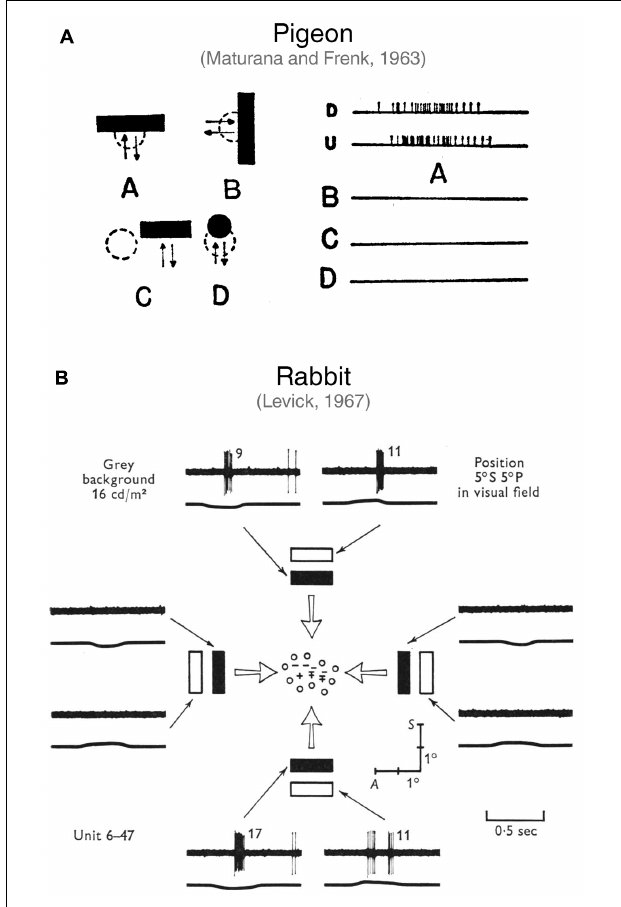
FIGURE 2 | First studies describing orientation-selective ganglion cells in vertebrate retinae. (A) Discovery of horizontally tuned OSGCs in the pigeon retina by Maturana and Frenk (1963). In A (right side), the firing of a pigeon OSGC in response to a horizontal bar moving downward (D) or upward (U) is represented. As shown in B, C and D, the same cell does not respond to a vertically oriented bar moving leftward or rightward (B), nor to a horizontal bar presented over the receptive field surround (C), or to a small spot moving over the receptive field center (D). Image taken from Maturana and Frenk (1963) with permission. (B) Characterization of OSGCs in the rabbit retina by Levick (1967). Spiking responses of an OSGC to light or dark bars with different orientations moving across the receptive field center. The mapping of the receptive field center is also represented at the center of the schematic. The ‘+’ symbol indicates responses to a stationary spot at light ON; ‘–’, at light OFF; ‘ ± ’, at both light ON and OFF; ‘o’, no response detected. The traces show the spiking responses elicited by the bars (upper trace; number of spikes is reported after each response) and the output of a photomultiplier focused on the receptive field (lower trace; an upward deflection indicates light increase). Note that only horizontally oriented bars elicited responses. A, Anterior; S, superior. Image taken from Levick (1967) with